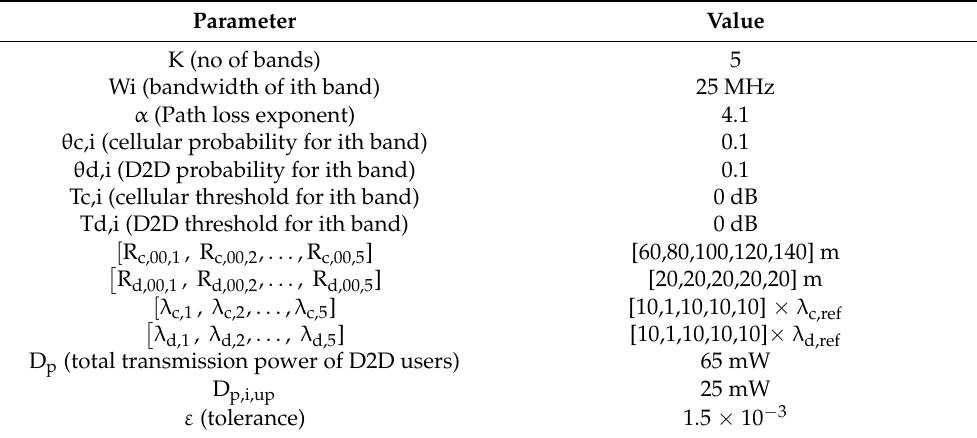
Table 2. Simulation parameters by using the modified derivative algorithm.